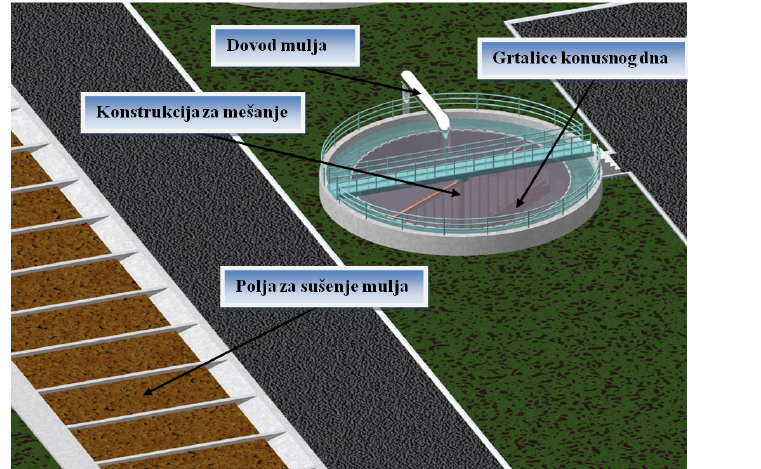
Figure 6 – 3D Model of the Sludge Treatment Plant